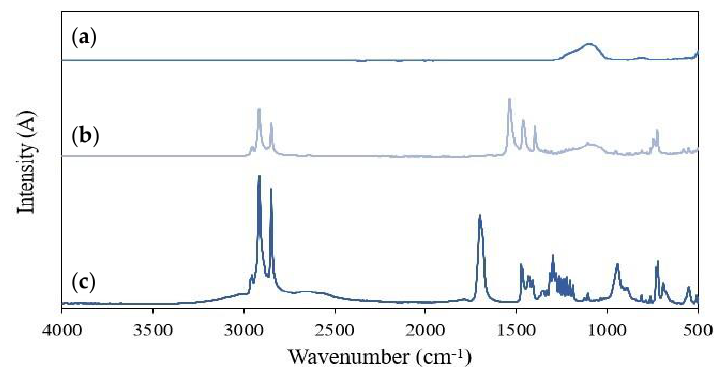
Figure 10. FTIR spectra of ( a ) SiO 2 ( b ) hydrophobic sample and ( c ) stearic acid.